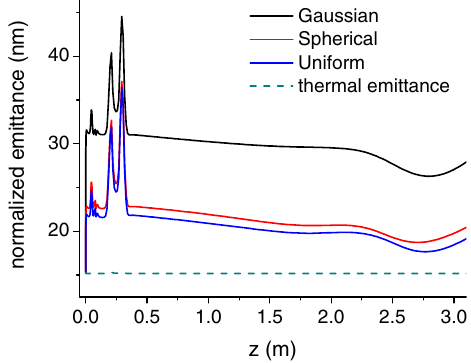
FIG. 9. Comparison of the optimal emittance for Gaussian, spherical, and uniform initial transverse distributions from the cathode (all have 20 (cid:1) m rms spot sizes) for a gun gradient of 120 MV = m . For the Gaussian profile the nonlinear transverse space charge forces at the beam edge lead to slice emittance growth. For spherical and uniform cases the transverse space charge forces are more linear and the compensated projected emittance is closer to the thermal emittance level. In the later cases 1 pC, sub-20 nm beams are